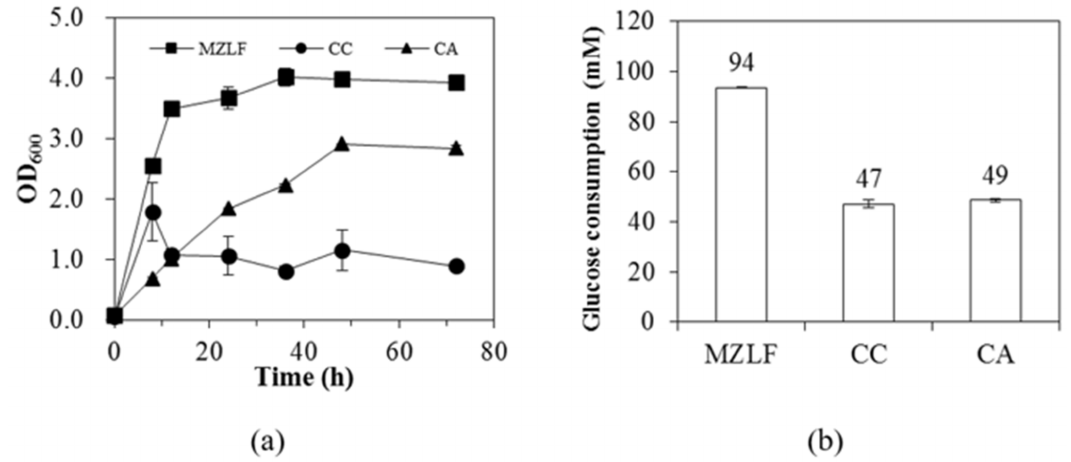
Figure 1. ( a )The growth curve and ( b ) glucose consumption of E. coli strains MZLF, CC, and CA. M9 minimal salts with 111 mM glucose and 2 g / L yeast extract was used. The standard deviation was used for the error with n (biological replicates) ≥ 3. The genotypes of E. coli MZLF, CC, and CA are E. coli BL21(DE3) ∆ zwf, ∆ ldh, ∆ frd, MZLF ( ∆ ppc ), and MZLF ( ∆ ppc , ∆ pta ). The genes ppc and